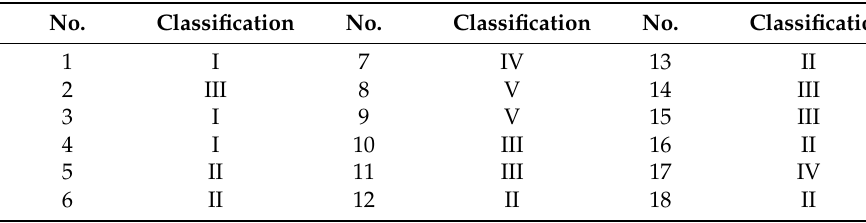
Table 14. Results of the proposed